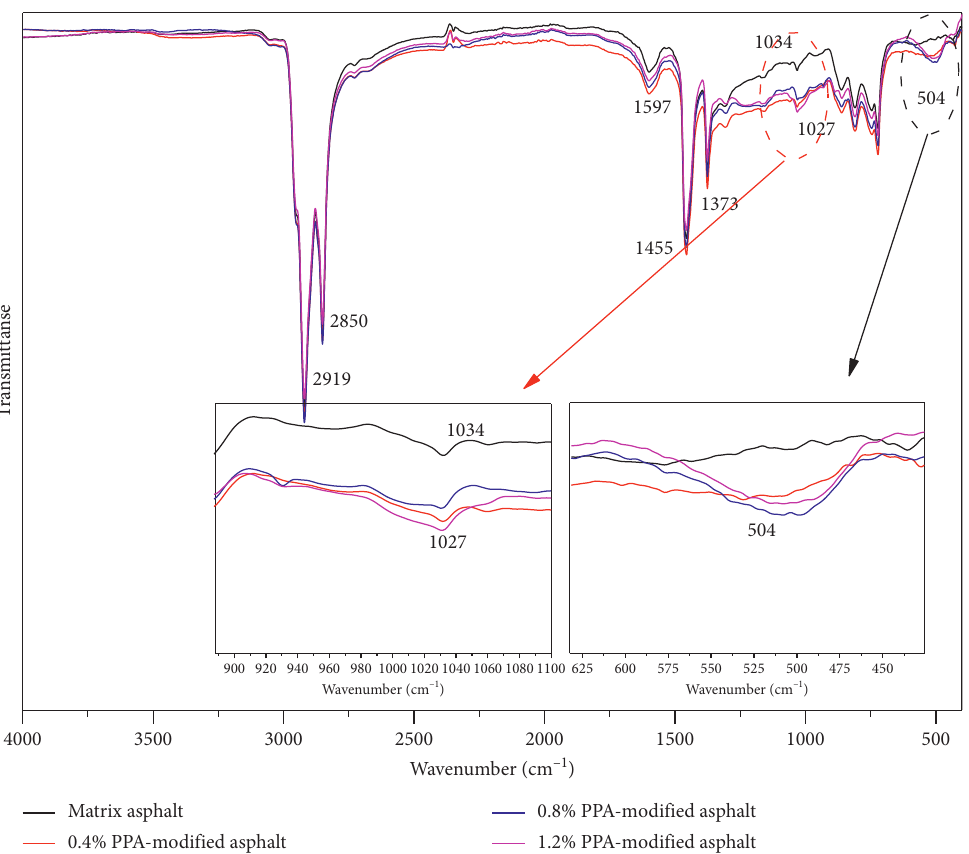
Figure 9: FTIR spectra of matrix asphalt and modified asphalt with different PPA contents (insets are the magnified spectra near 1027cm − 1 and 504cm − 1 ).